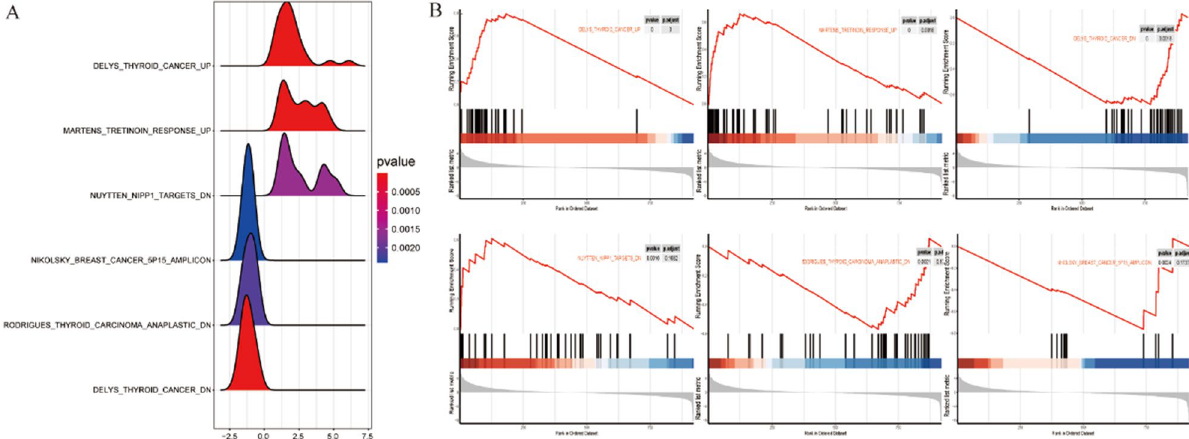
Figure 4. GSEA of all target genes based on differential lncRNAs. ( A ) Volcano map showing an overview of the GSEA results. ( B ) The results show that pathways (such as delys thyroid cancer up, martens tretinoin response up, and nuytten NPP1 targets dn) were significantly enriched in tumor tissues from patients with THCA. In contrast, the delys thyroid cancer dn, Rodrigues thyroid carcinoma anaplastic dn, and Nikolsky breast cancer 5p15 amplicon pathways were significantly downregulated in tumor tissues from patients with